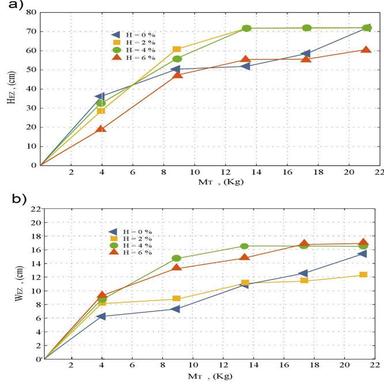
a) EZ height and b) EZ width as a function of accumulated masses, for different contents of moisture.